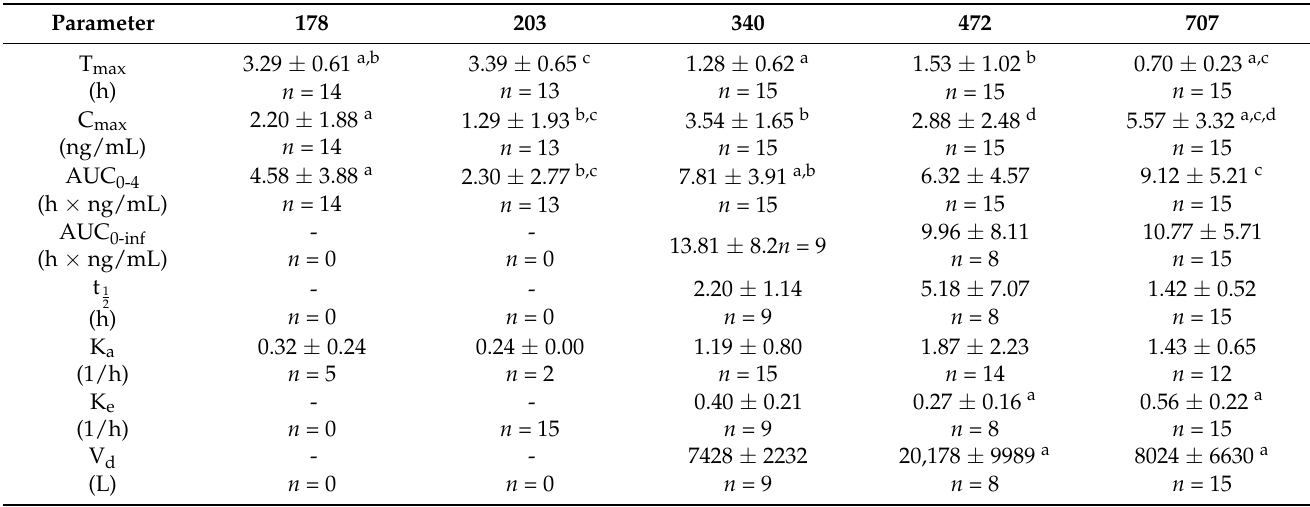
Table 2. Features of the cannabidiol (CBD) preparations.